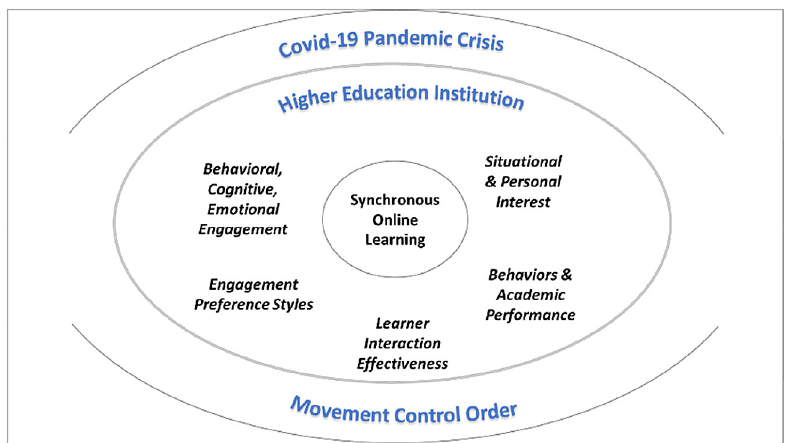
Figure 4. Conceptual framework. COVID-19 = coronavirus disease 2019.